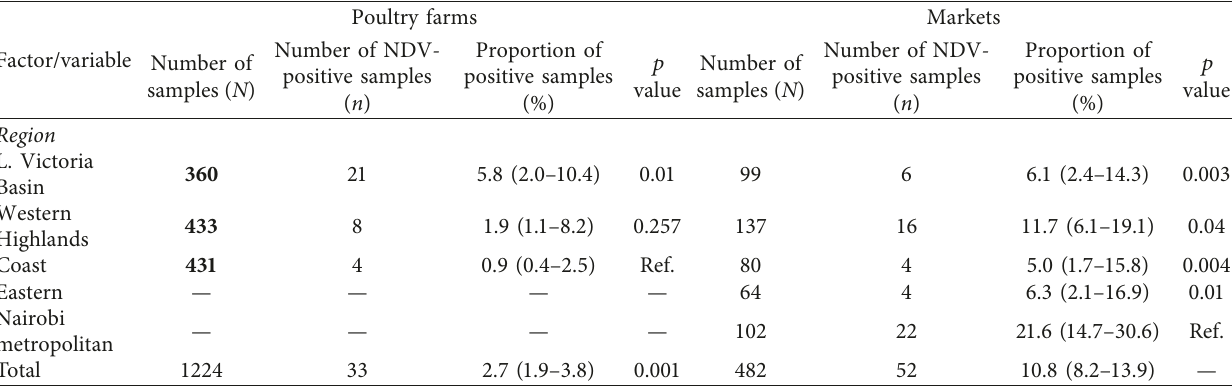
Table 2: Newcastle disease virus detection by the molecular assay in backyard poultry farms (BPFs) and live bird markets (LBMs) in different regions of